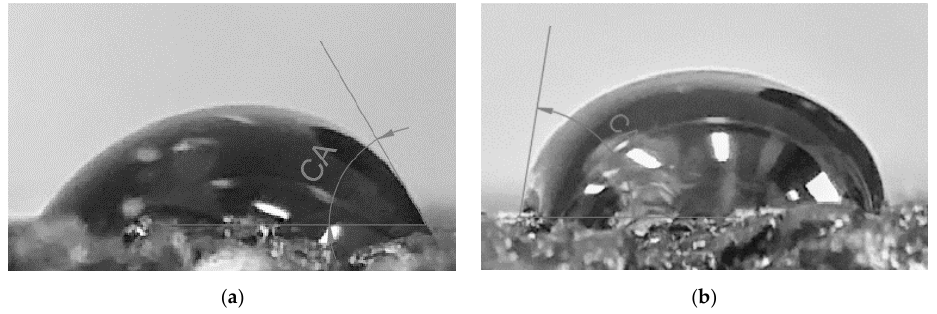
Figure 5. SEM microstructures of mineral–asphalt mixtures (1000× and 2000×): ( a ) WC-1; ( b ) WC-2. Figure 6 presents the exemplary photos of CA water measurements of WC-1 and WC-2 mineral– asphalt mixtures. The SFE values for all analyzed bituminous mixes were calculated by means of Neumann’s method on the basis of the CA measurements.